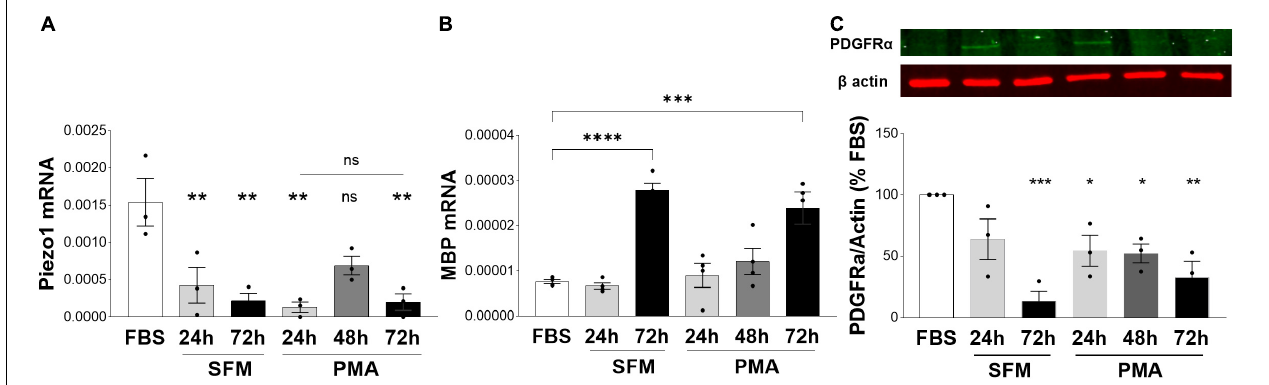
FIGURE 4 | Expression of Piezo1 decreases in MO3.13 oligodendrocytes during maturation. (A) The mRNA expression of Piezo1 receptor in MO3.13 oligodendrocytes is downregulated already after 24 h of both, serum-free media (SFM) (28 ± 16% SFM 24 h vs. FBS) and SFM supplemented with PMA (8 ± 4% PMA 24 h vs. FBS). At 48 h of treatment with PMA (data not collected for 48 h SFM) Piezo1 mRNA briefly increases (45 ± 8% PMA 48 h vs. FBS, p = 0.0522) indicating a temporary upregulation of Piezo1 signaling during oligodendrocyte maturation. Data presented as mean ± SEM, One-way analysis of variance with Sidak’s multiple comparison’s test, p = 0.013, N = 3 independent experiments. ∗∗ p < 0.01 (B) SFM (365 ± 20% SFM 72 h vs. FBS) and PMA (314 ± 46% OMA 72 h vs. FBS) treatment induce MO3.13 oligodendrocyty maturation. Data presented as mean ± SEM, One-way analysis of variance with Sidak’s multiple comparison’s test, p < 0.0001, N = 4 independent experiments. ∗∗∗ p < 0.001, ∗∗∗∗ p < 0.0001 (C) Representative WB image of OPC marker PDGFR α shows steadily decreasing levels of PDGFR α protein in MO3.13 oligodendrocytes stimulated with PMA or cultured in SFM. Data presented as mean ± SEM, One-way analysis of variance with